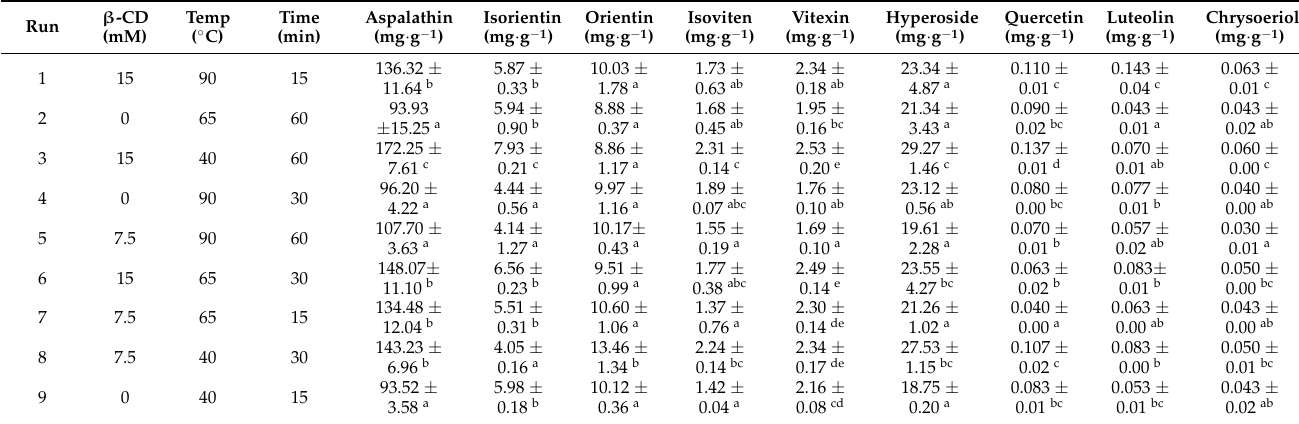
Data represented as polyphenols of green rooibos crude plant extracts expressed as mean ± standard deviation ( n = 3). ANOVA and Duncan’s multiple range tests were performed. a–e Means with different letter superscripts within and between columns denotes significant differences ( p < 0.05).